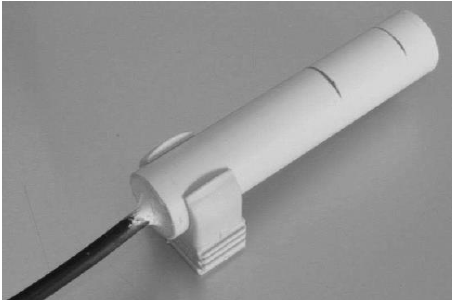
Figure 11. Capacitance probe fully assembled.